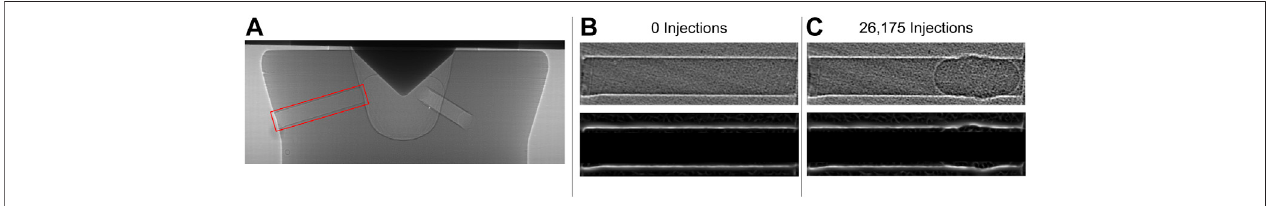
FIGURE2|(A) AprojectionimageofAM3-2nozzlewith0injections.Theregionwiththeori fi ceofinterestishighlighted. (B) .Theori fi ceregioncroppedandrotated, acquiredat 0 injections (top). Image after applyinga Sato fi lter (bottom). (C) Thesame ori fi ce imagedafter 26,175injections withULSD (top). Image after applyingaSato fi lter (bottom).